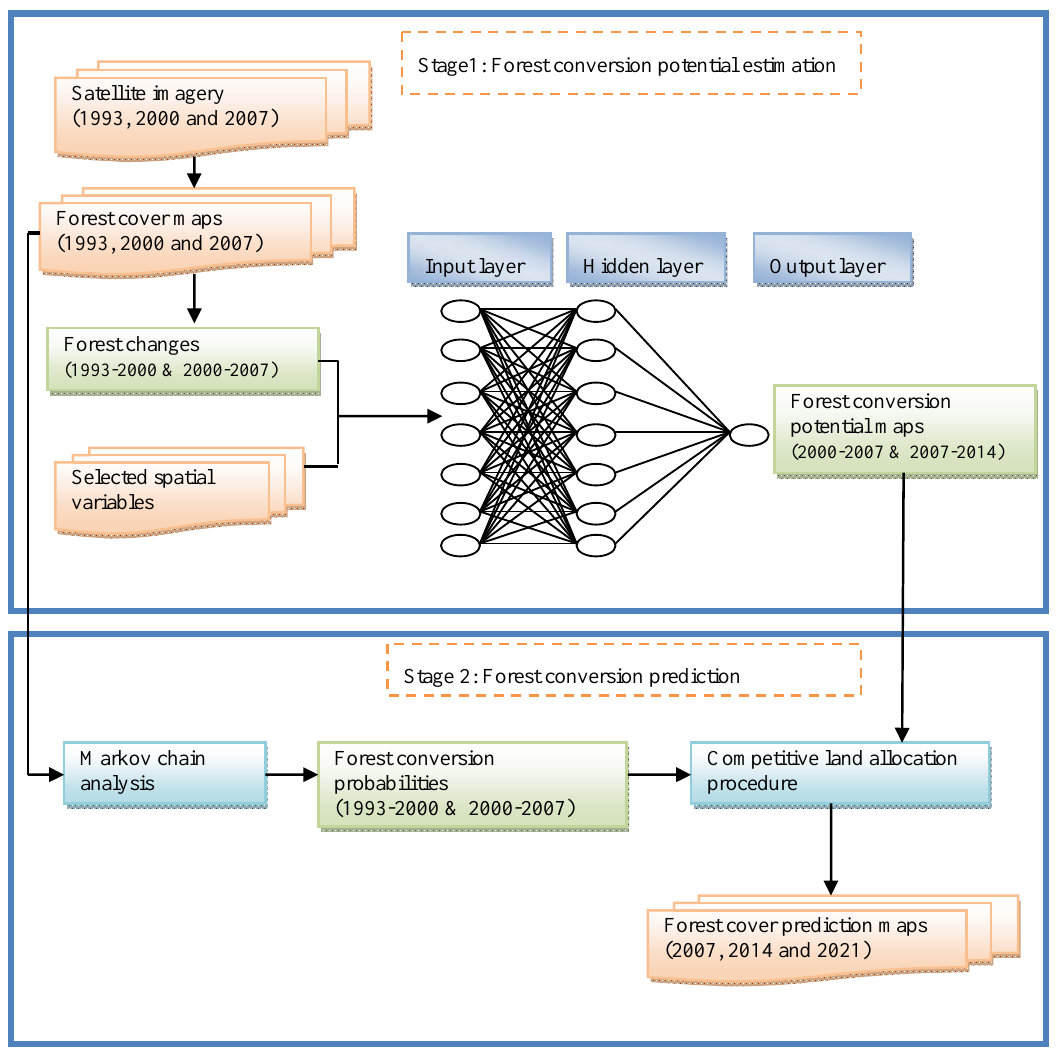
Figure 3. Flowchart of the MLPNN-M model for predicting forest